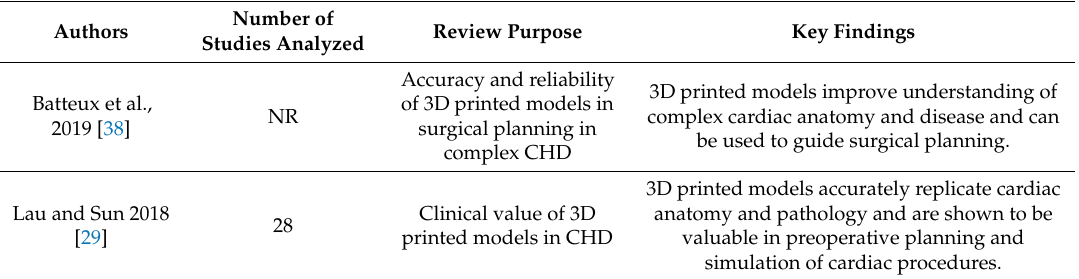
Table 2. Summary of systematic reviews of 3D printed models in congenital heart